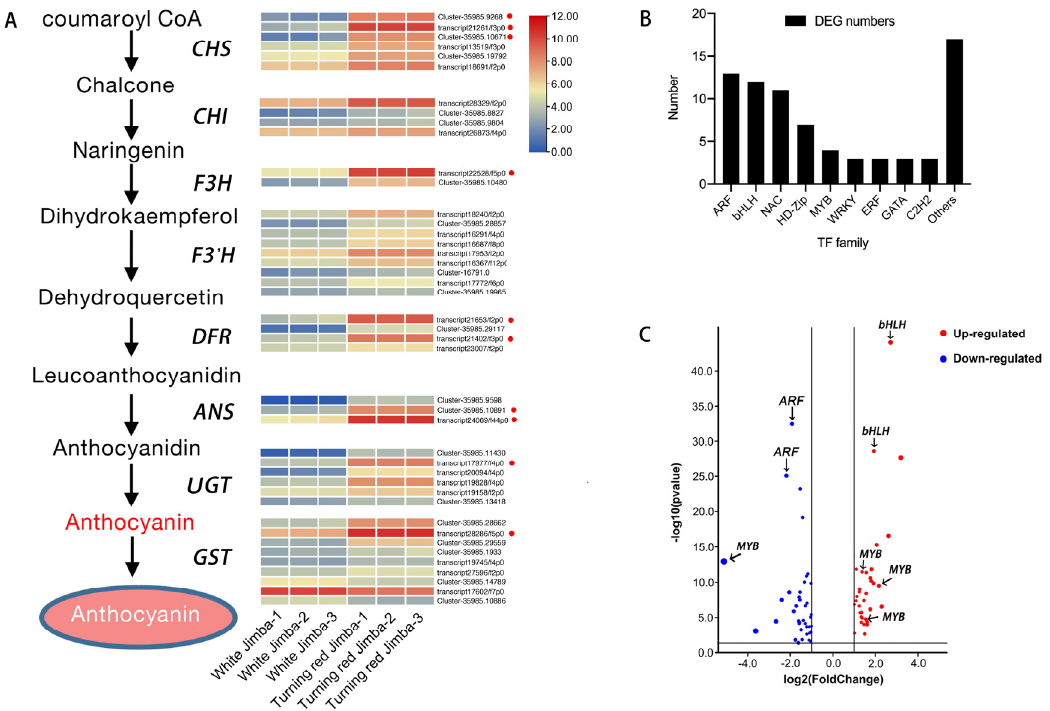
Figure 3. DEGs of anthocyanin pathway genes and transcription factors. ( A ) Anthocyanin pathway genes and heatmap of anthocyanin pathway genes in white and turning red ‘Jimba’. Gradient colors represent log 2 FPKM in gene expression, while color from blue to red represents the expression levels from low to high. The top 10 transcripts with the most significant change were designated with red solid circles. ( B ) Numbers of differentially expressed transcription factors in each family. ( C ) Volcano plot of differentially expressed transcription factors. DEGs of MYBs and bHLHs and the most significantly changed TFs were marked with